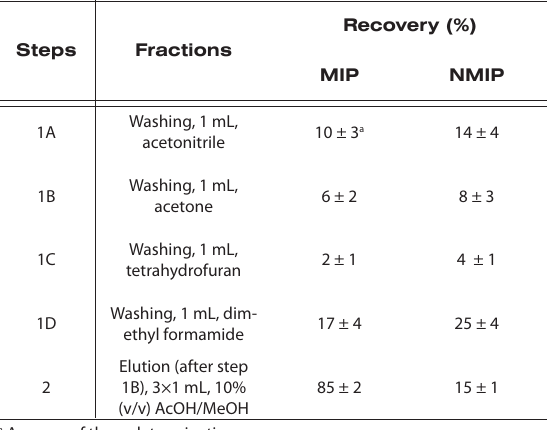
Table 2. Recovery (%) obtained after the loading of 50 mg of MIP and NMIP .